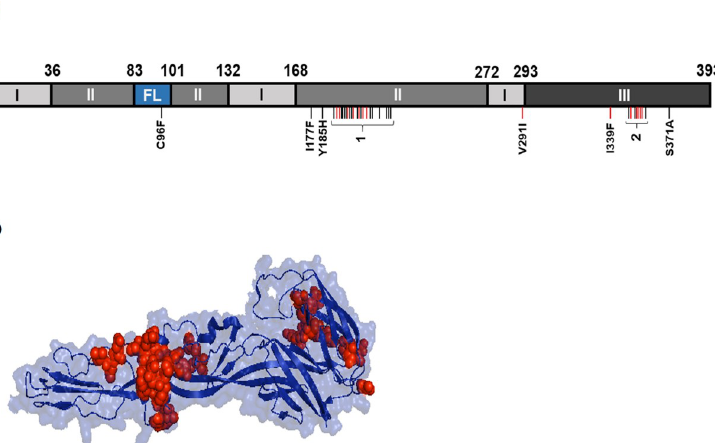
Fig 5. Sites of intrapatient mutations in CHIKV E1 protein. (A)Linear diagram of CHIKV E1 protein (adapted from Voss et al[18] indicating protein domains, amino acid positions (top) and the positions of amino acid mutations (vertical bars) including two mutational hotspots (1 & 2) with the following mutations in order of location: 1 = Y189D, P191T/A/H/R/S, F192V/C/L/S/Y/I, G193D, A194E/G, A195R, R196S/G, P197Q/T, G198V, Q199H/K, F200V/I/C/L, D202E, I203S/T, Q204L/H/P, S205R/G, T207M, E209A, S210R, Y214X, Q218P/H, L219R, V220G; and 2 = N349K, S350A, L352W, Q353K/P, I354S/L/T, S355A/P, F356C/L/S, T358P). Red bars indicate mutations with frequencies > 0.01 and that were present in > 50% of patients or mutations present in the consensus sequence of a single patient. FL, fusion loop. (B) Structural model of native CHIKV E1 protein indicating the locations of intrapatient point mutations